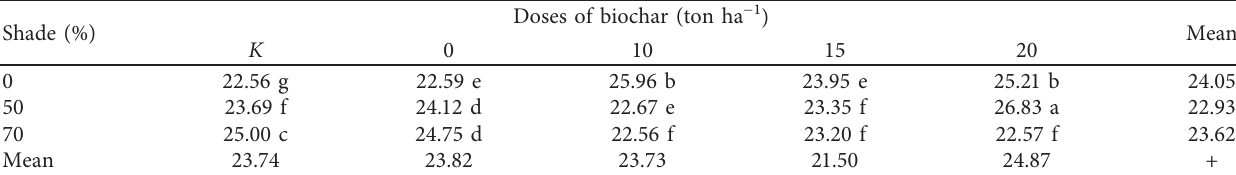
Table 6: Effects of biochar and shade application on the soil moisture content (%).